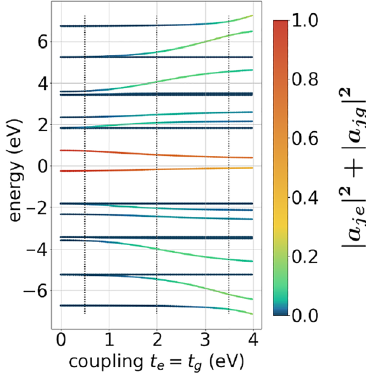
Figure 14: Energy levels of a hybrid system consisting of an armchair triangular graphene flake with 18 atoms and an adatom with energy = 0.75 eV and E = − 0.25 eV (breaking the electron–hole levels E e g symmetry), located over the left top-most site of the flake. The line color represents the occupation of the adatom sites as in Figure